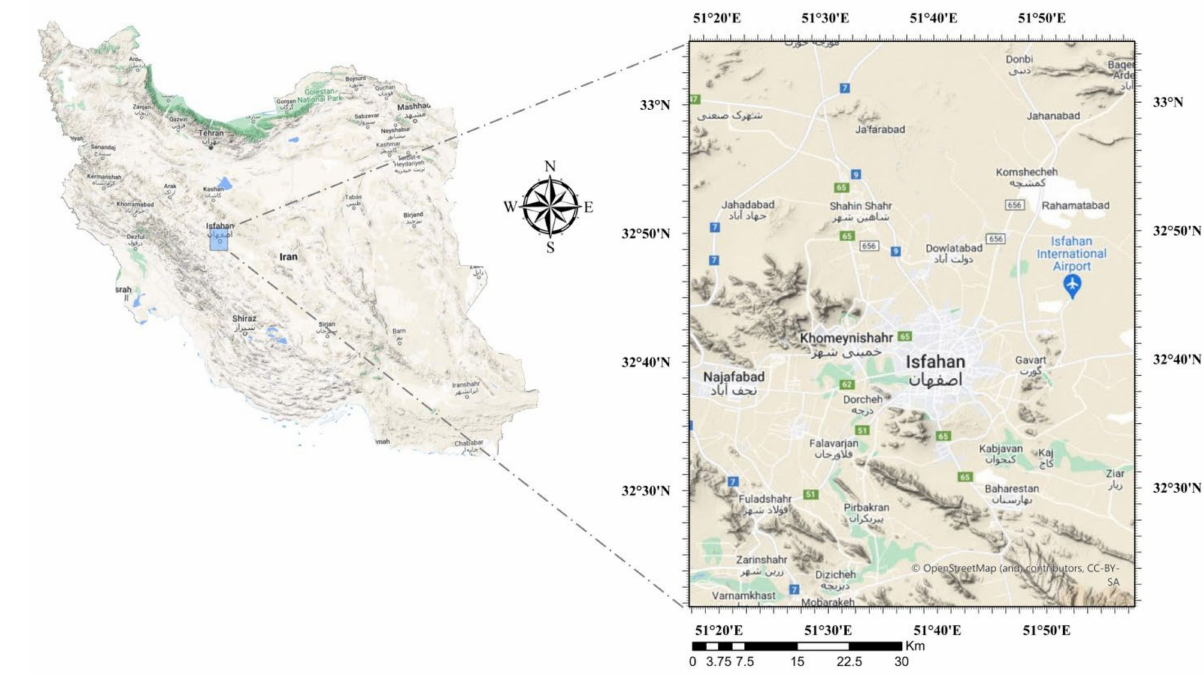
Figure 1. Study area.